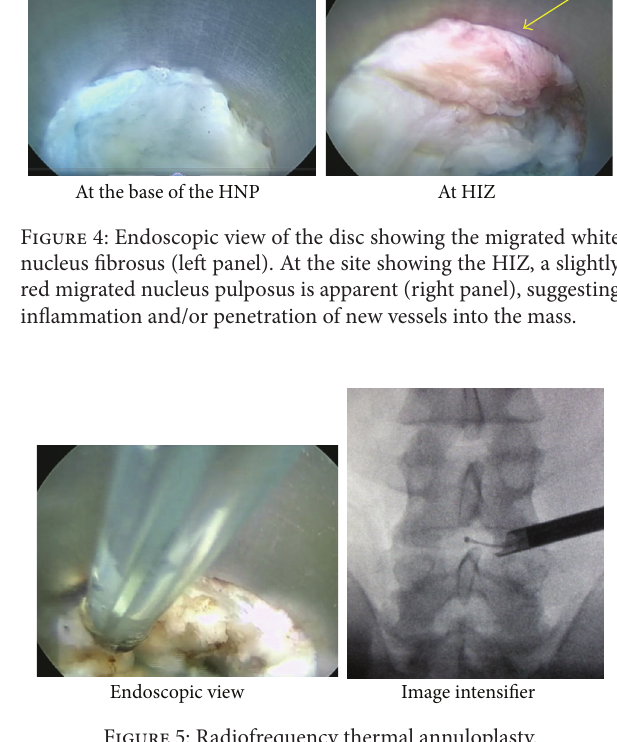
Figure 5: Radiofrequency thermal